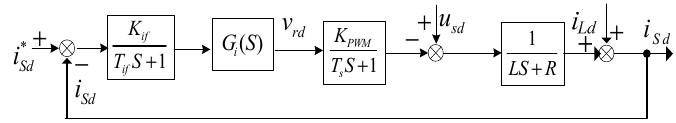
Figure 5. The current loop of the d-axis control diagram.